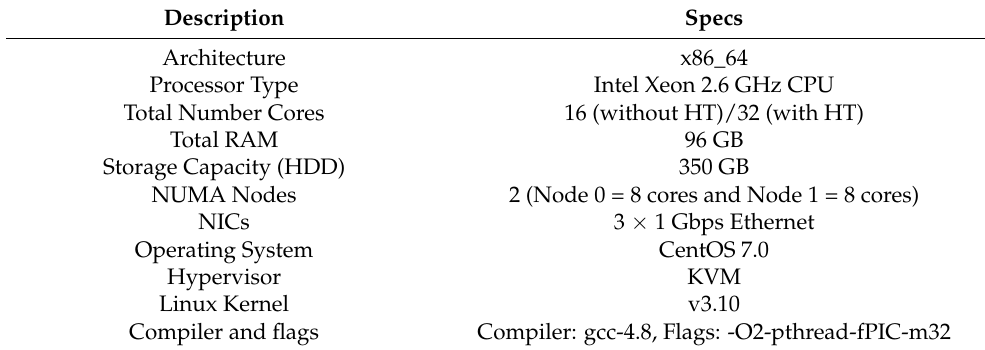
Table 1. Specification of the physical